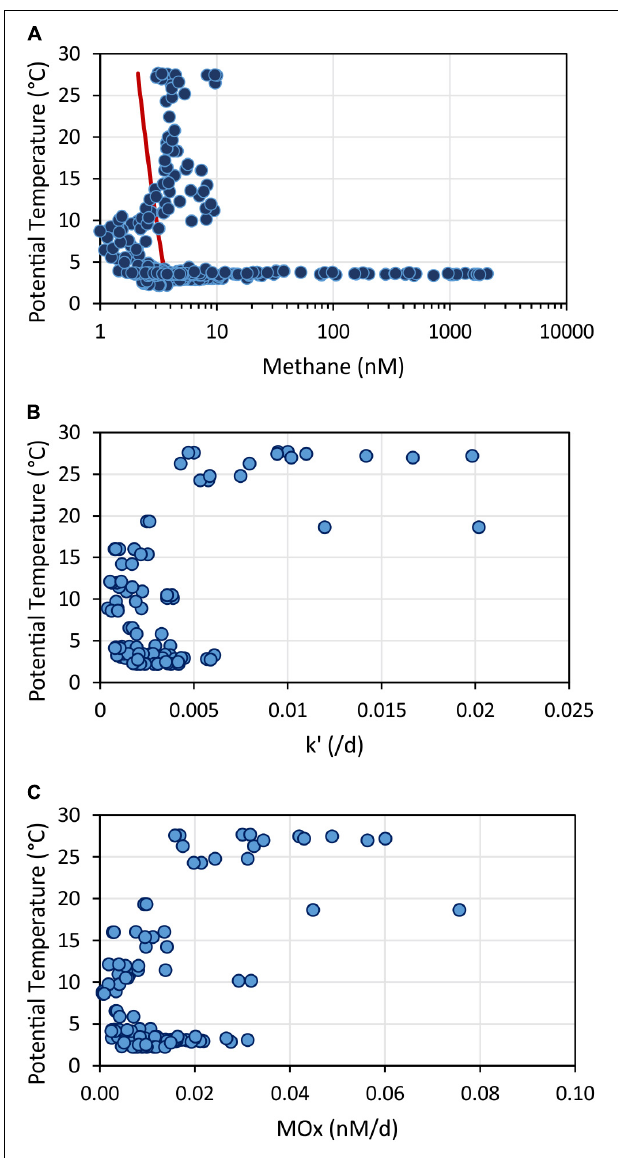
FIGURE 13 | Methane concentrations (A) , relative activities of methane oxidizing microbes – k’ (B) , and aerobic methane oxidation rates – MOx (C) plotted against potential temperature. The red line in (A) shows the calculated methane concentration in atmospheric equilibrium. Values greater than the equilibrium concentrations indicate a source of methane occurring in the upper water column at temperatures > 10 ◦ C. In contrast, methane oxidation rates and relative activities were enhanced in water with temperatures > 20 ◦